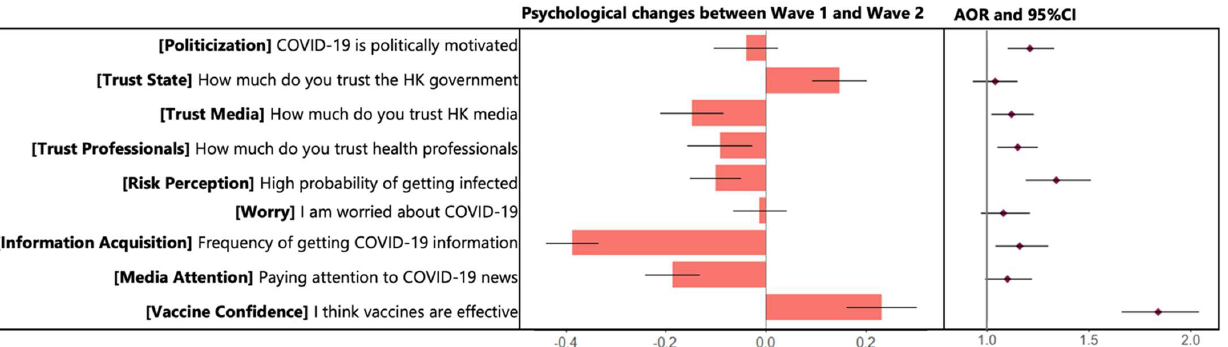
Figure 2. Measured changes in psychological perceptions between two waves and association with vaccination acceptance. Chart demonstrates Adjusted Odds Ratio (AOR) with age, gender, education, income, and health status as covariates and 95% Confidence Intervals (CIs). Hong Kong citizens showed increased trust and satisfaction with the efforts of government authorities to fight COVID-19, decreased trust in HK media, increased knowledge about COVID-19 and the vaccine, increased coping with vaccine and virus-related risks, and decreased information acquisition.